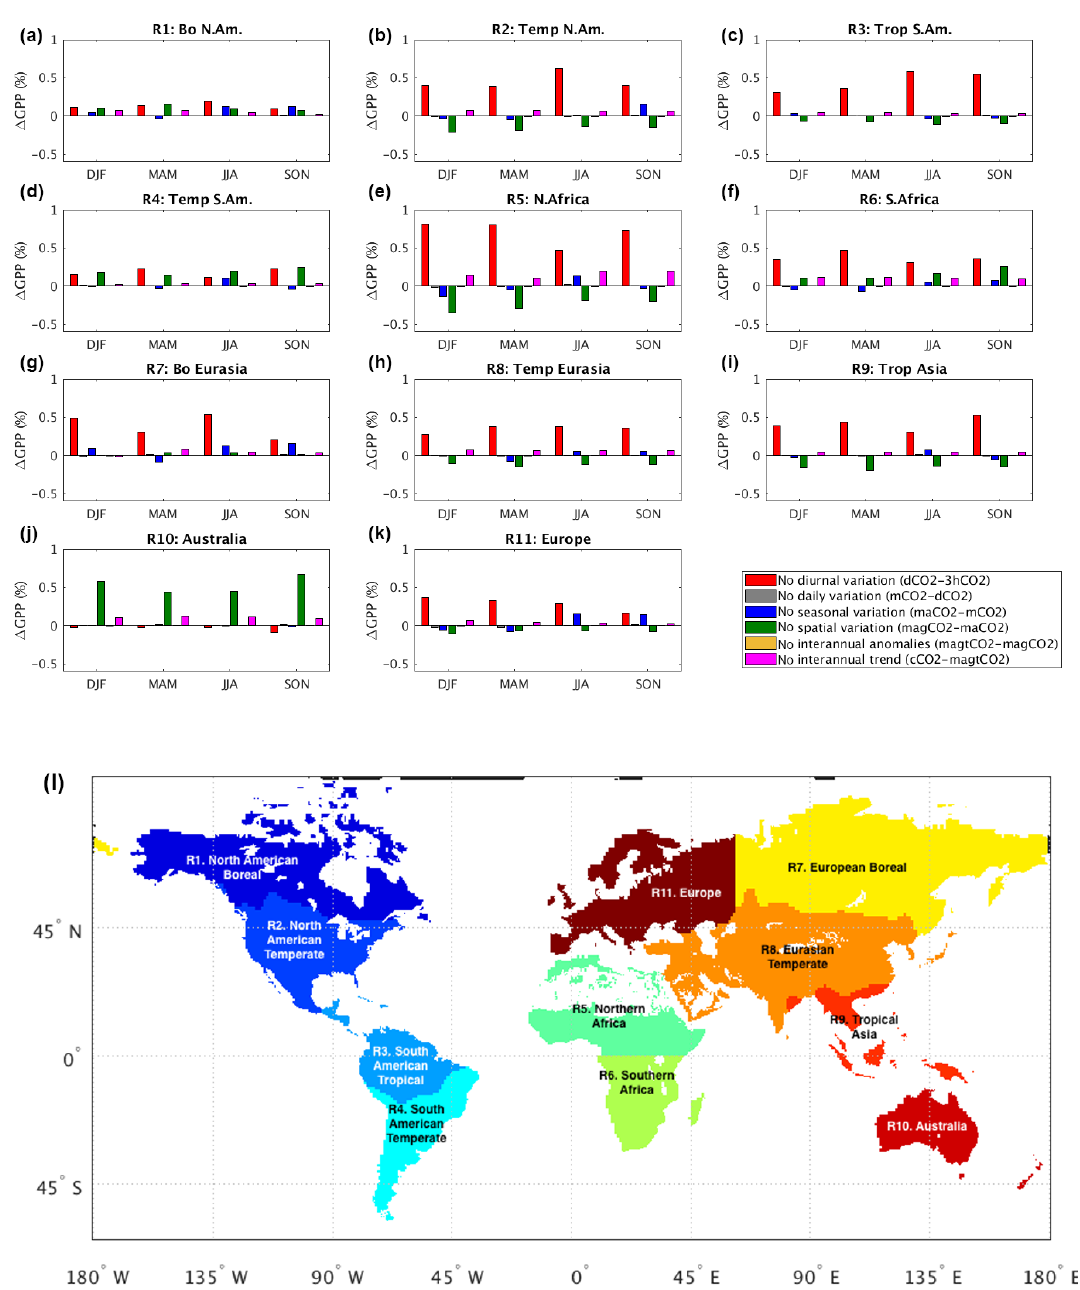
Figure 8. Regional- and seasonal-scale impacts of spatiotemporal CO 2 variabilities on GPP. Incremental change in GPP associated with each added facet of CO 2 variability is shown as a percentage of the previous experiment’s regional GPP. The map in (l) shows the regional boundaries of TransCom land regions (reconstructed from the basis function map in http://transcom.project.asu.edu/transcom03_protocol_ basisMap.php, last access: November